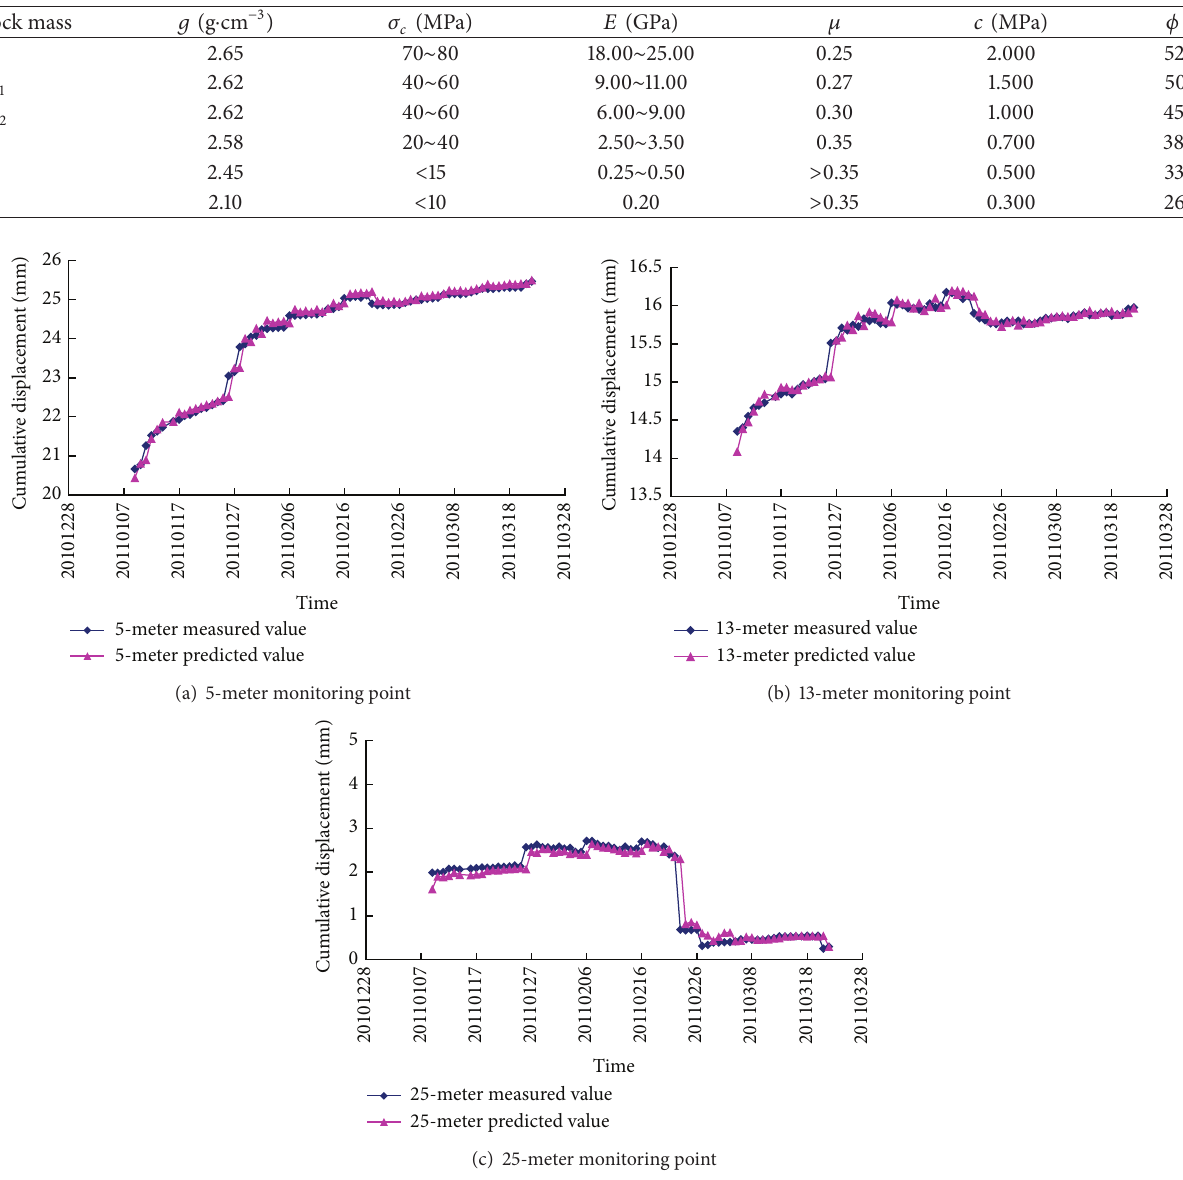
Table 1: Parameters employed in the numerical simulations.